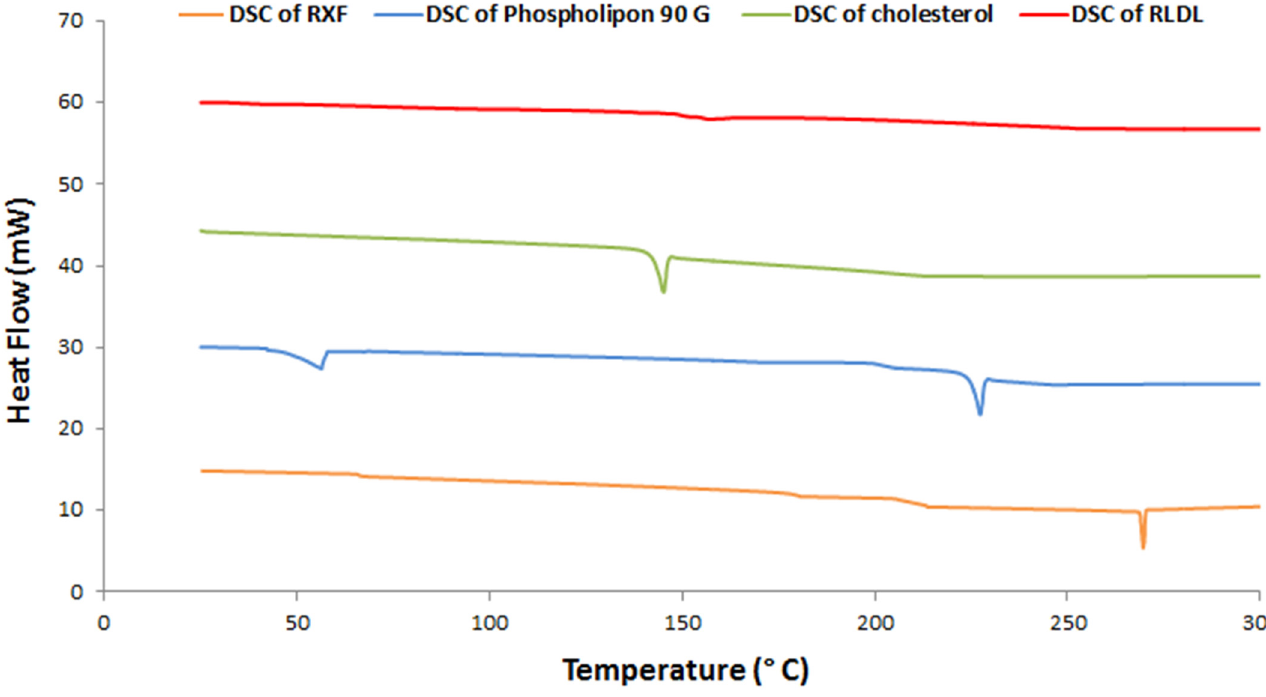
Figure 3. DSC thermogram of optimum RLDL formulation components.